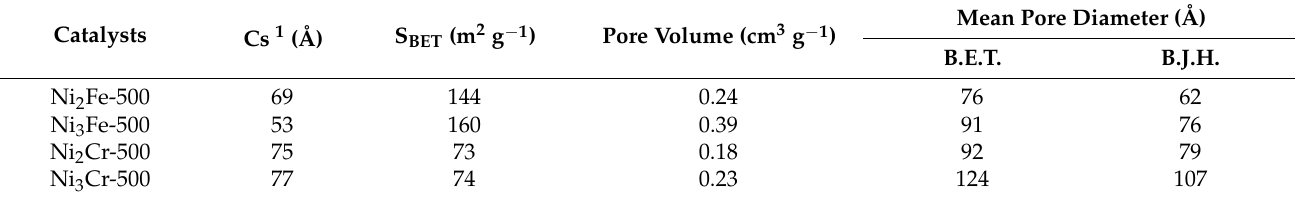
Table 3. Textural properties of Ni-based catalysts.